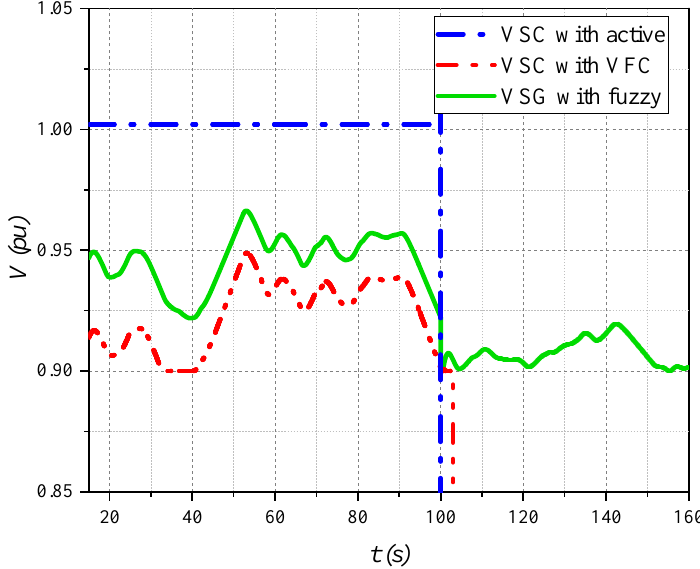
Figure 16. Microgrid frequency statistics for different scenarios.